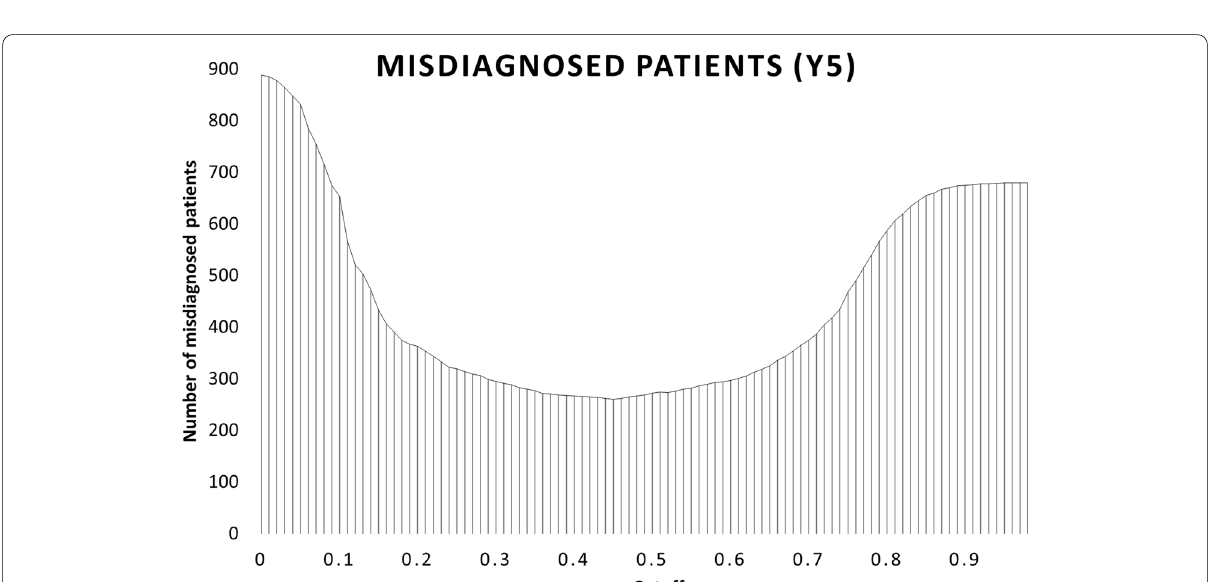
Fig. 2 Misdiagnosed at different cutoffs. Total number of misdiagnosed patients at the end of the 5th year of follow‑up ( y axis) at different cut‑off points ( x axis) for the Delta Study